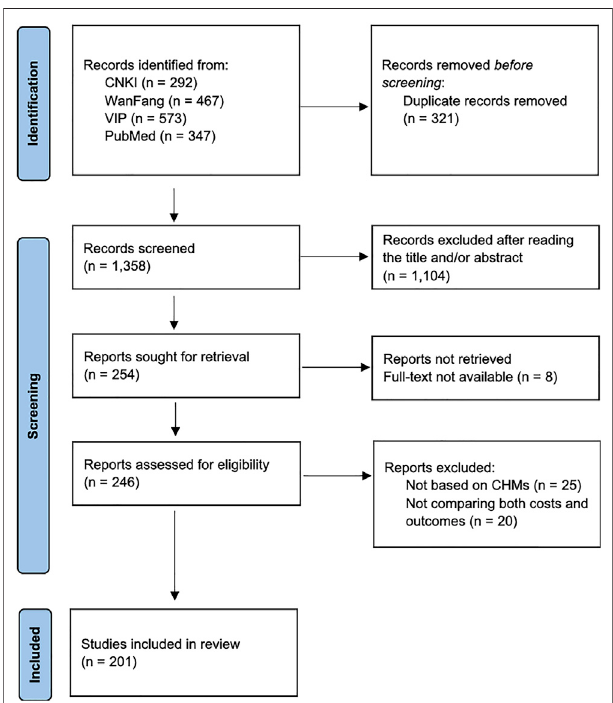
FIGURE 1 | PRISMA fl ow diagram of the literature screening process. PRISMA, Preferred Reporting Items for Systematic Reviews and Meta-